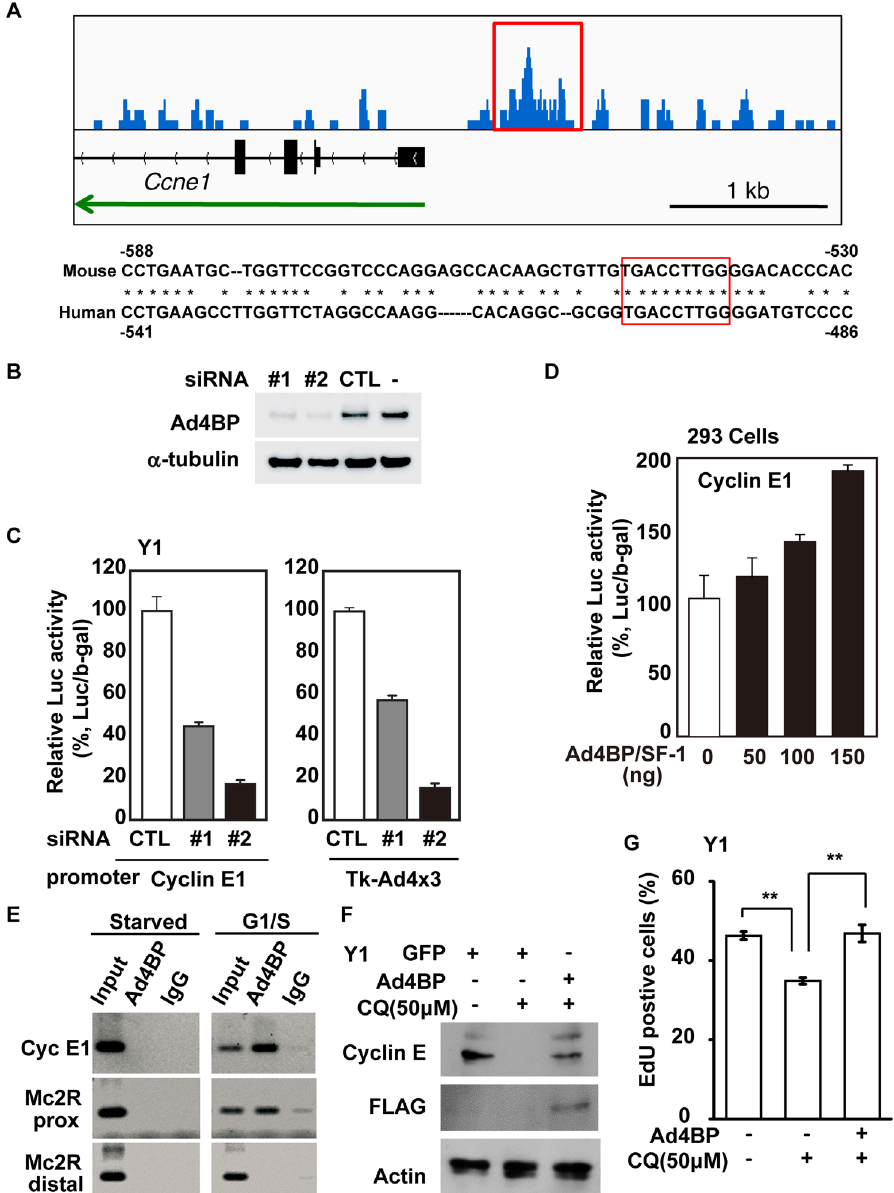
Figure 6. Ad4BP/SF-1 binds to the promoter of Ccne1 . ( A ) Visualization of the accumulation of Ad4BP/SF-1 at promoter region of Ccne1 gene (upper). A green arrow shows the direction of Ccne1 gene. Nucleotide sequences of the ChIP-peak regions are compared between mouse and human (bottom). A red box indicates conserved binding sequence for Ad4BP/SF-1. ( B ) Ad4BP/SF-1 is depleted by siRNA efficiently. Whole cell extracts of siRNA against Ad4BP/SF-1 (#1 and #2) transfected Y1 cells are analyzed by immunoblot with antibodies against Ad4BP/SF-1 and α -tubulin. ( C ) A Ccne1 -Luc was transfected into Y1 cells with siRNAs against Ad4BP/SF-1 (#1 and #2). Average values and SDs of the luciferase activities are indicated. The relative luciferase activity is shown: the amount of Ad4BP/SF-1 activation in the presence of control siRNA set at 100%. n = 3. Tk-Ad4 × 3-Luc was used as a positive control. ( D ) Ccne1 -Luc were transfected into HEK293 cells and with increasing amounts of the expression vector for Ad4BP/SF-1. The relative luciferase activity is shown: the amount of Ad4BP/ SF-1 activation in the absence of expression plasmid of Ad4BP/SF-1 set at 100%. n = 3. ( E ) Chromatin was prepared from Y-1 cells either at G0 or G1/S phase. The binding of Ad4BP/SF-1 to Ccne1 promoter was examined by ChIP. The proximal and distal upstream regions of Mc2R gene were used as positive and negative control, respectively. The normal rabbit IgG was used as a negative control for immunoprecipitation. ( F , G ) Overexpression of Ad4BP/SF-1 restores cyclin E1 expression ( F ) and S phase entry ( G ) in CQ (50 μ M)-treated Y1 cells. Whole cell extracts of GFP or Ad4BP/SF-1 overexpressed Y1 cells in the presence or absence of CQ (50 μ M) were analyzed by immunoblot with antibodies against cyclin E1, FLAG, and actin. ( G ) Quantitation of EdU incorporation in Ad4BP/SF-1 overexpressed Y1 cells in the presence or absence of CQ (50 μ M). ** P <